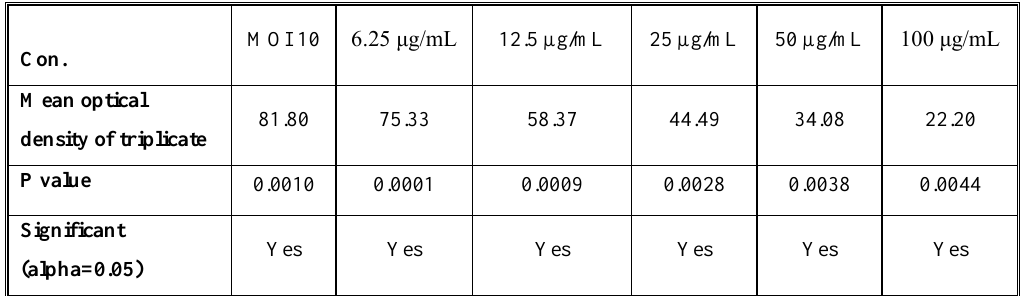
Table 2. The statistical result of the tested sample (aqueous layer) against the cytotoxicity of measles virus using MOI of 10.